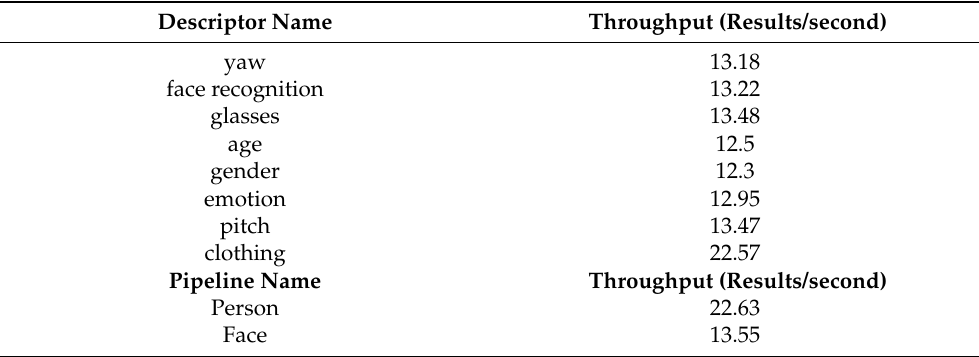
Table 1. Descriptor throughput and pipeline throughput resulting for the customer intelligence application measurements obtained deploying the system in a cluster of two nodes and one worker for each